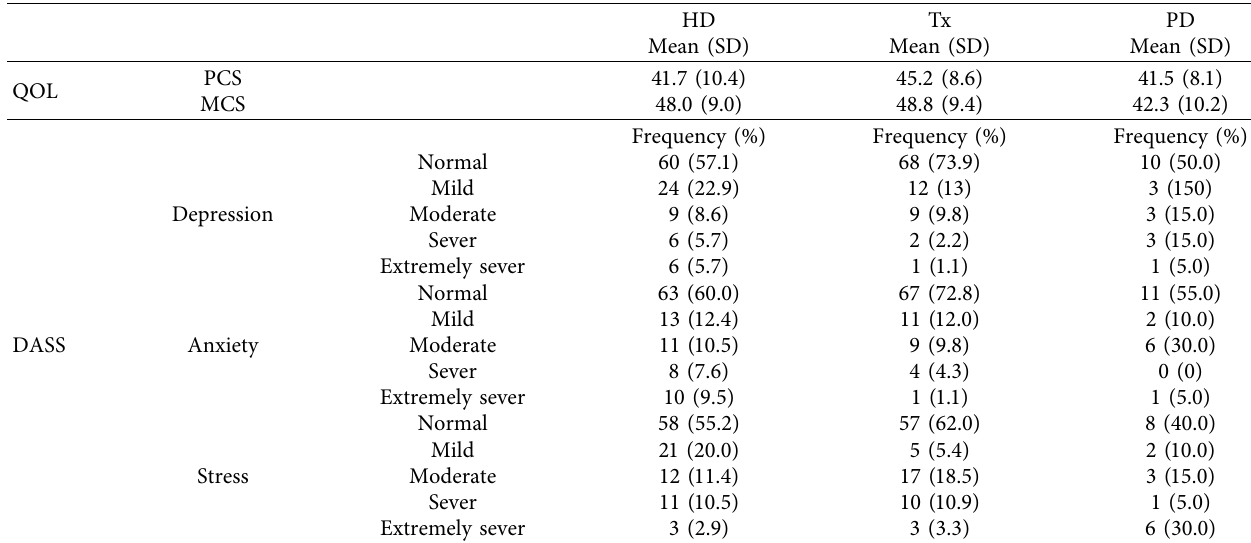
Table 2: Mean score and frequency for QOL and DASS domains.